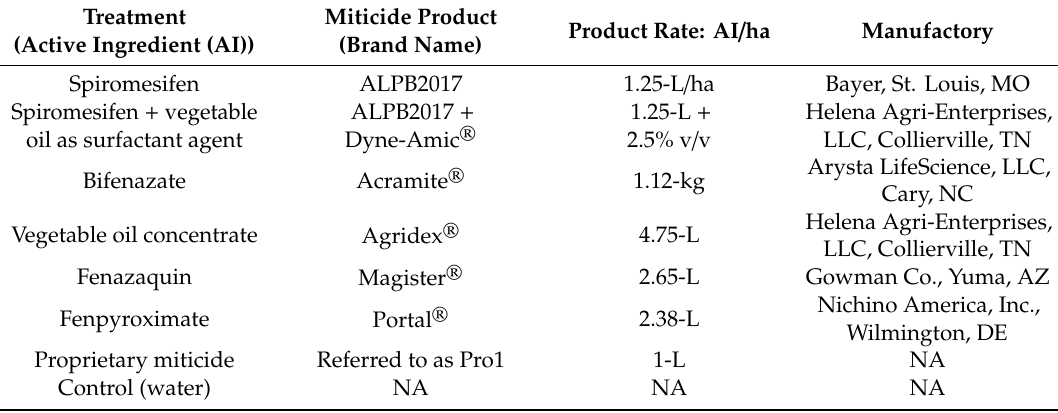
Table 1. List of miticide products tested and the label recommended rate used for control of Oligonychus